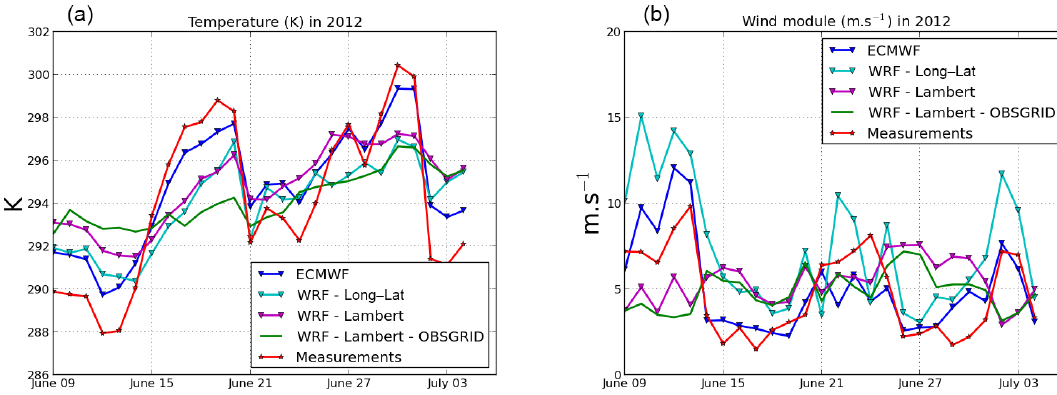
Figure B1. Ground temperature (a) and wind speed (b) at Ersa during the summer 2012.